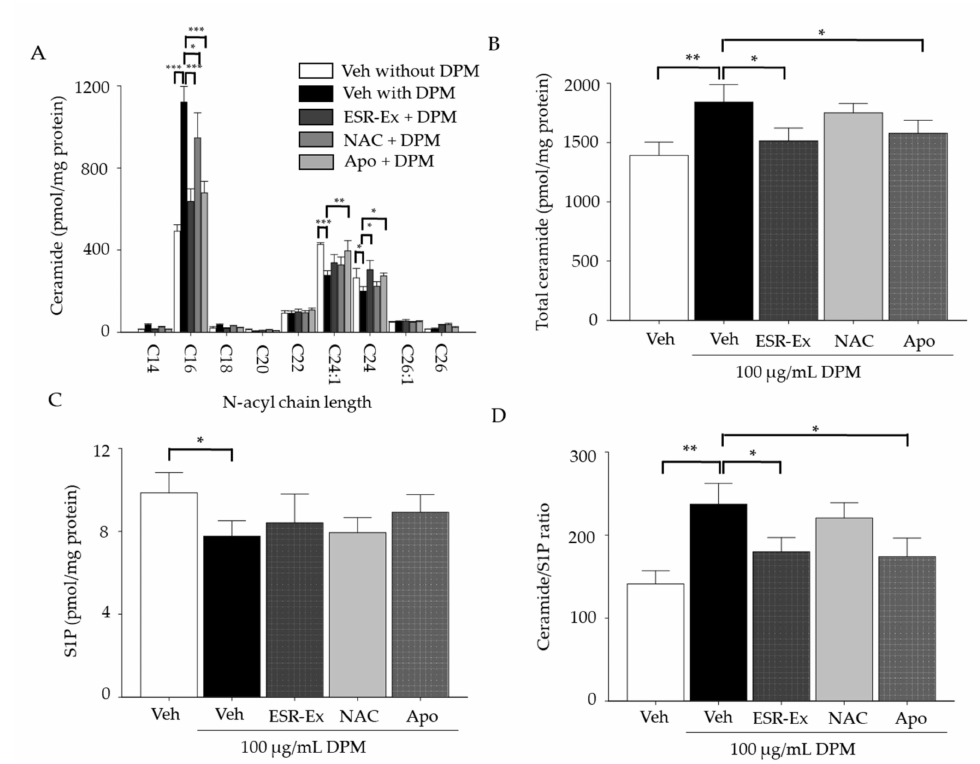
Figure 3. ESR-Ex suppresses increases in total ceramide production and alteration of ceramide molecular profiles and normalizes the ratio of ceramide to S1P in KC exposed to DPM. KC were incubated with or without ESR-Ex (100 µ g/mL), NAC (1 mM), Apo (100 µ M) or vehicle for 30 min, and then further cultured with 100 µ g/mL of DPM for 24 h. Total ceramide ( A ), ceramide species of different amide-linked fatty acid ( B ), sphingosine-1-phosphate ( C ), Ceramide/S1P ratio ( D ) were measured by LC-ESI-MS/MS. All values are mean ± SD ( n = 3). *** p < 0.001, ** p < 0.01, or * p < 0.05 vs. indicated group. See details in Materials and Methods